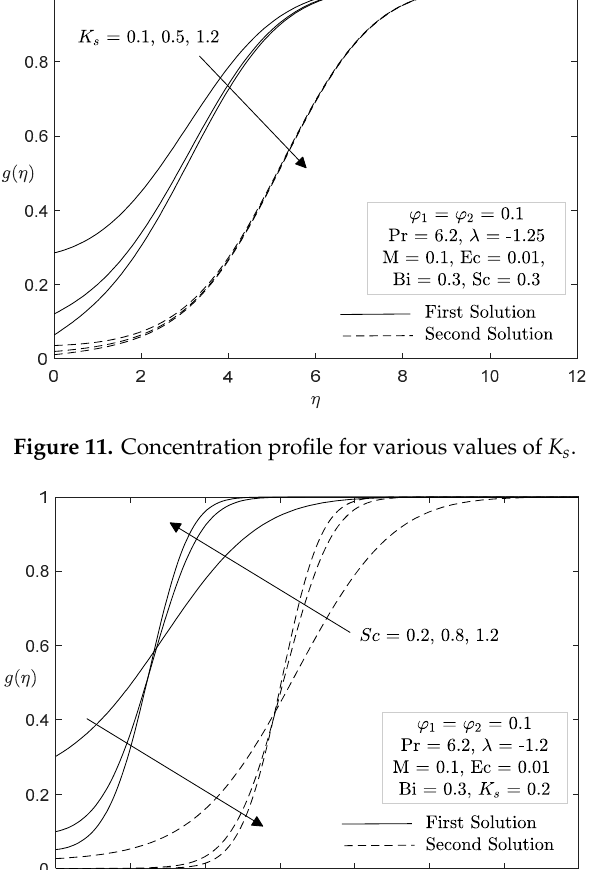
Figure 10. Temperature profile for various values of M .